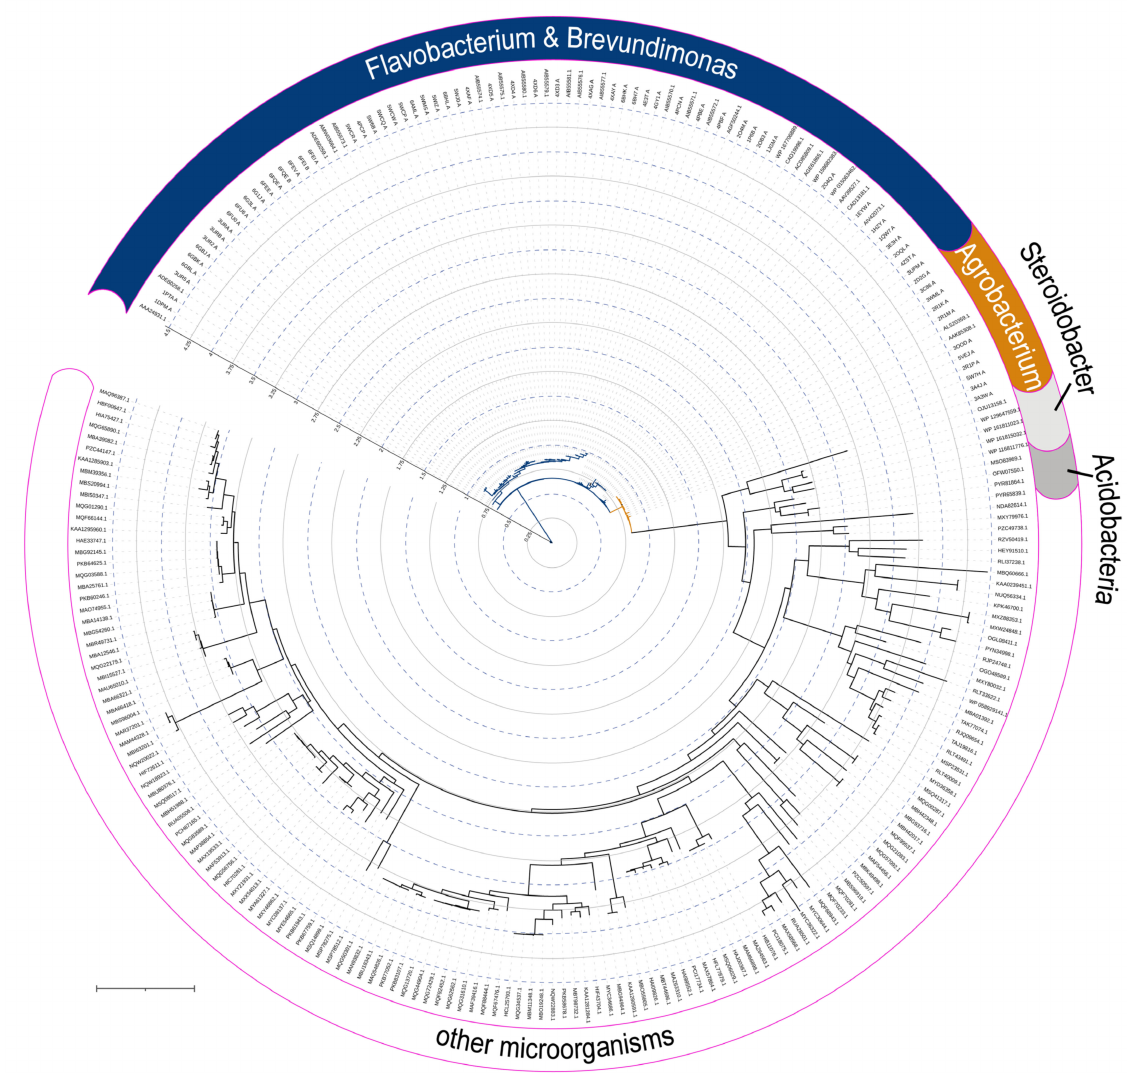
Figure 2. Phylogenetic tree of OPH and its homologous enzymes (down to 35% identity). Amino acid sequences were searched using BLAST (https://blast.ncbi.nlm.nih.gov/Blast.cgi) with PDB 1QW7 as a reference one; then they were multiply aligned with Clustal Ω (https://www.ebi.ac.uk/Tools/msa/clustalo/) and their tree was generated with IQ- TREE (http://iqtree.cibiv.univie.ac.at/); the tree was visualized with iTOL (https://itol.embl.de/). Though enzymes from Flavobacteria & Brevundimonas and Agrobacteria have similar high identity (89–100%), they were sub-divided and highlighted with blue and orange, respectively. Identifiers of individual transcripts/proteins according to NCBI/PDB are indicated on a roundabout. Internal scaling is shown for visualization purposes by solid grey and dashed blue